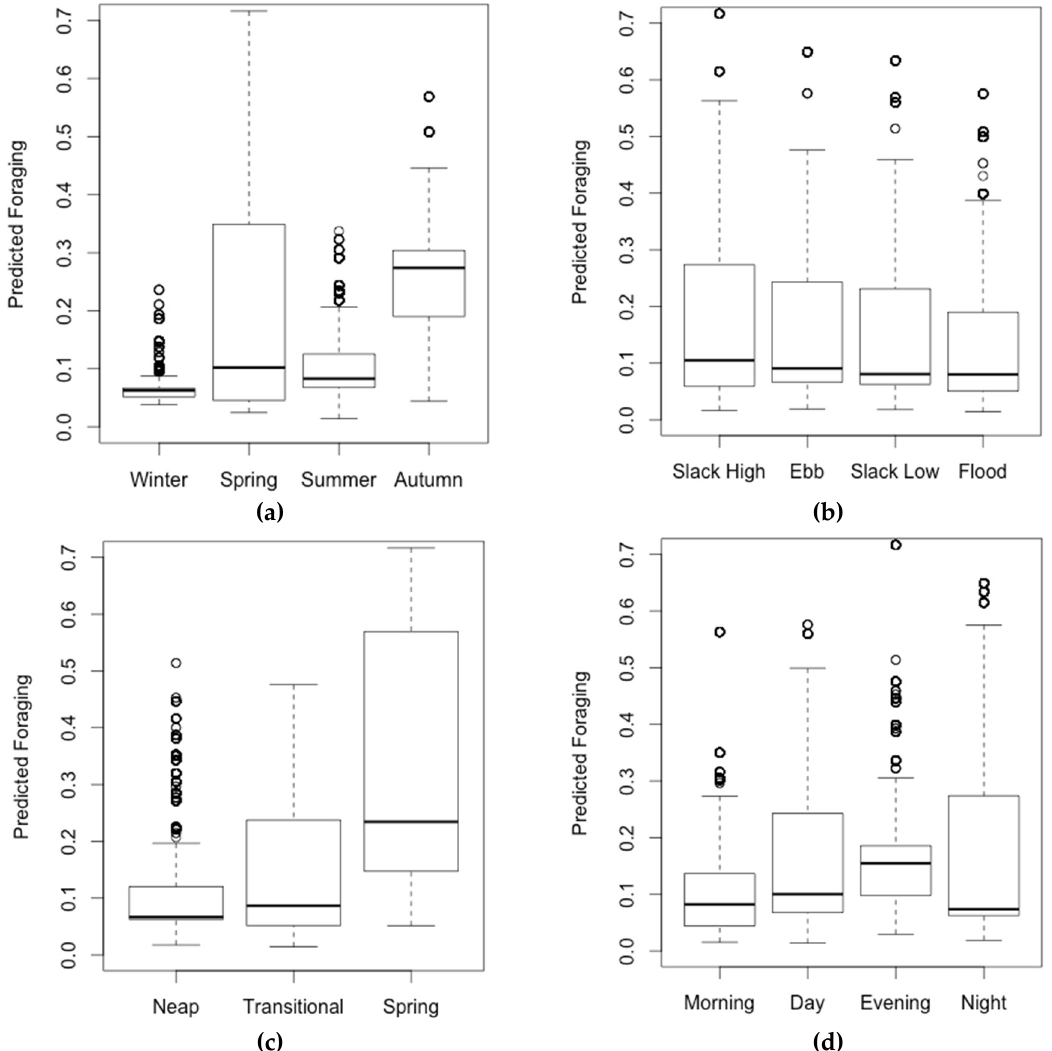
Figure 6. Predicted foraging at Foynes for the explanatory variables included in the best model: ( a ) Season; ( b ) Tidal Cycle; ( c ) Tidal Phase and ( d ) Diel Phase.